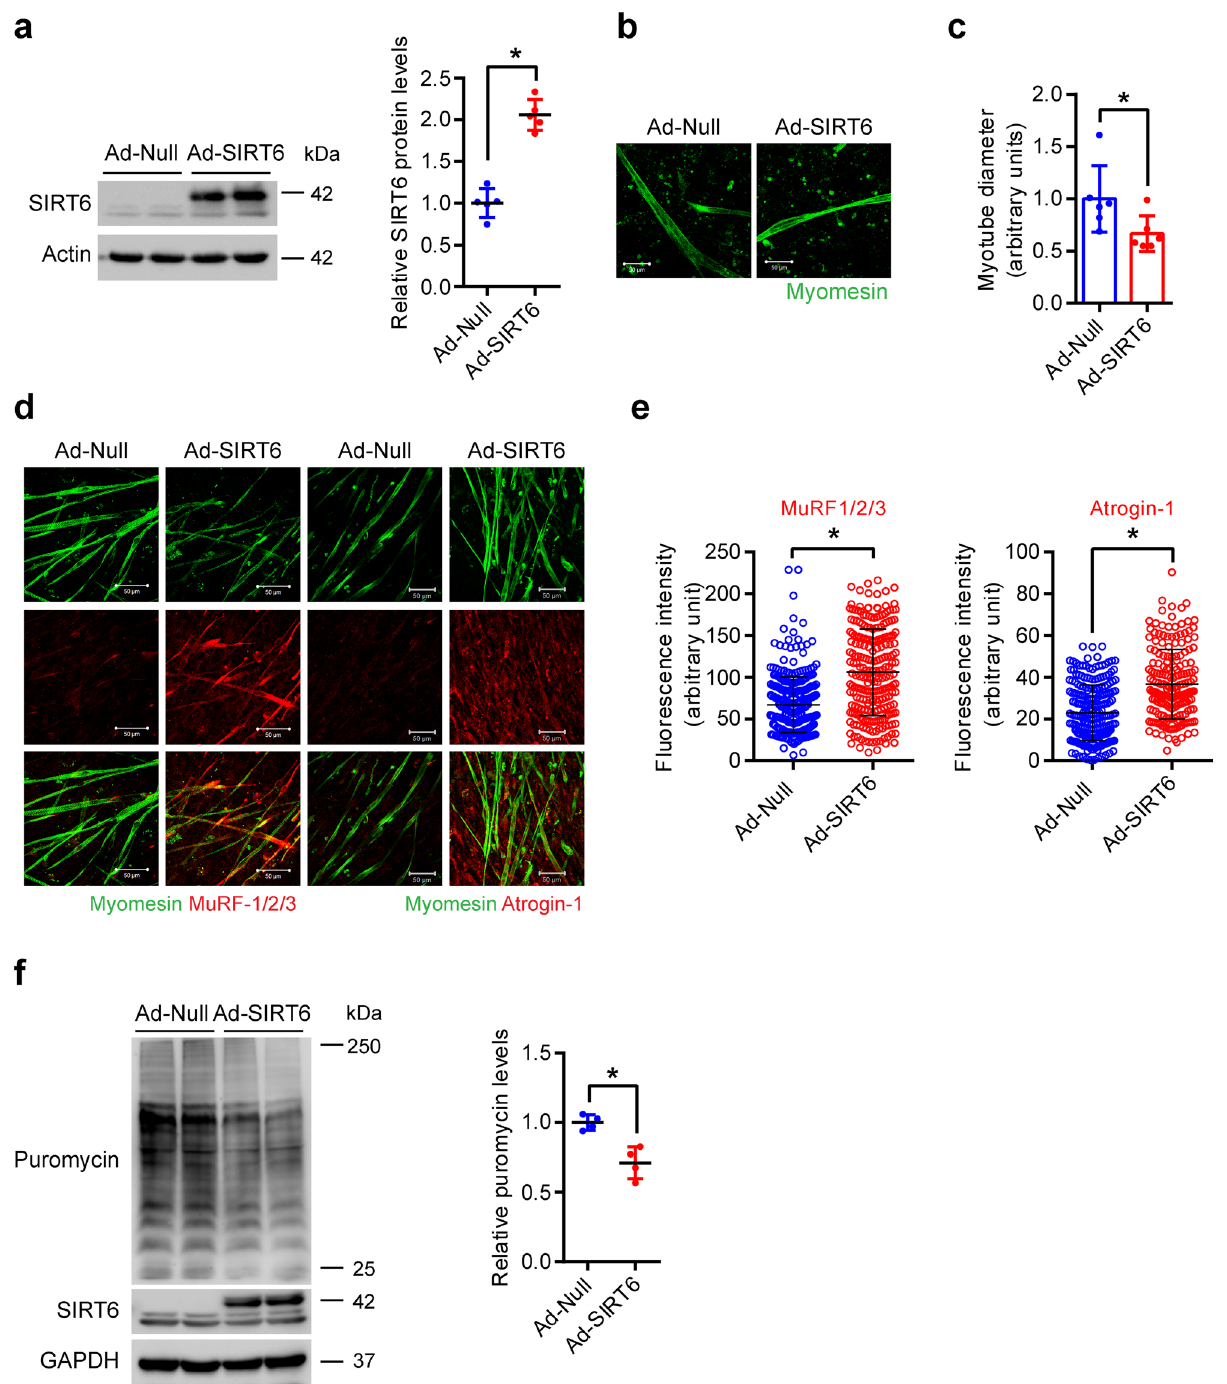
Fig. 2 | SIRT6 overexpression reduces myotube size. a Western blot (left) and relative quanti fi cation (right) to con fi rm overexpression of SIRT6 in adenovirus- infected myotubes. n =5. b Representative confocal images depicting reduction in myotube size upon SIRT6 overexpression in primary myotubes. The myotubes were stained green using an antibody against myomesin. Scale bar=50 µ m. c Quanti fi cation of fi ber diameter for myotube described in b . n =6. d Representative confocal images of MuRF-1/2/3 or Atrogin-1 levels upon SIRT6 overexpression in primary myotubes. MuRF-1/2/3 or Atrogin-1 were stained in red